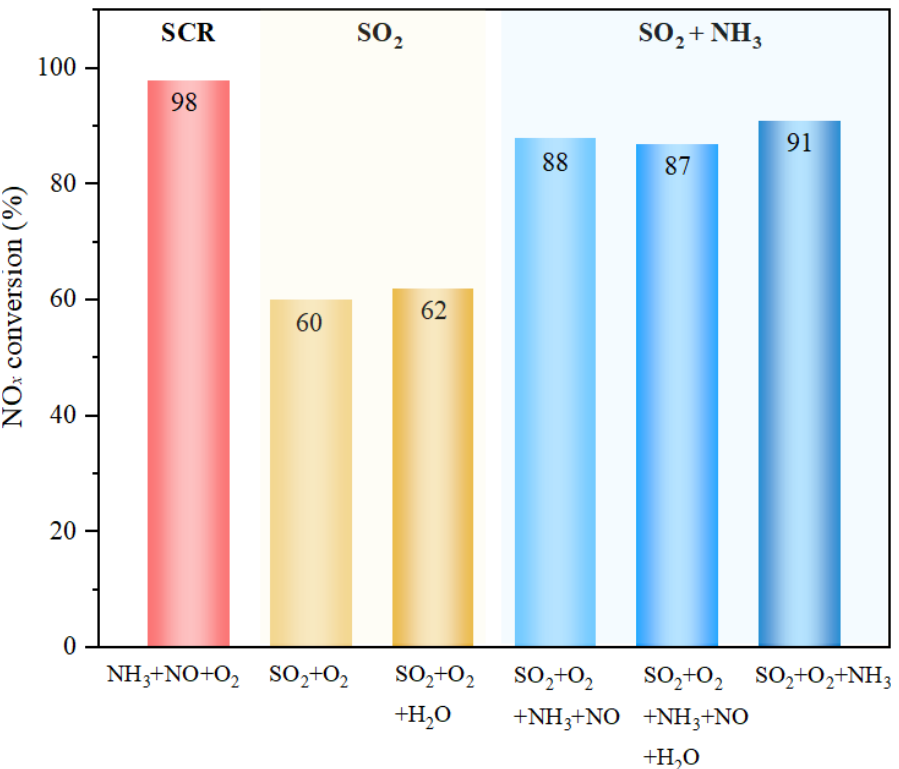
Figure 1. SCR activity of the treated CeNbTi catalysts. Reaction conditions: 500 ppm NO, 500 ppm NH 3 , 5% O 2 , 5% H 2 O, N 2 in balance, 300 °C, and GHSV = 80,000 h − 1 .